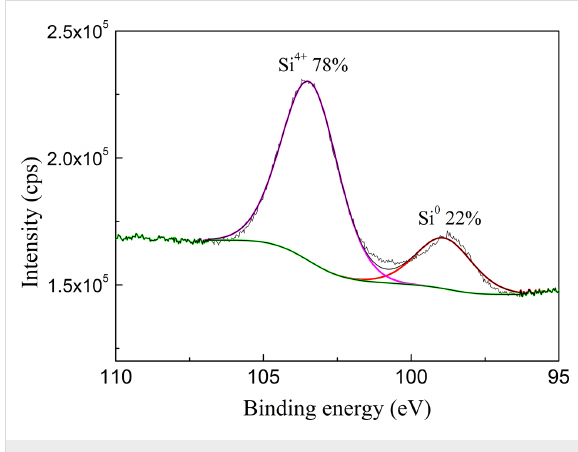
Figure 9: XPS result (Si region) for the 2.8 nm Au film on a Si(111) substrate annealed at 550 °C for 15